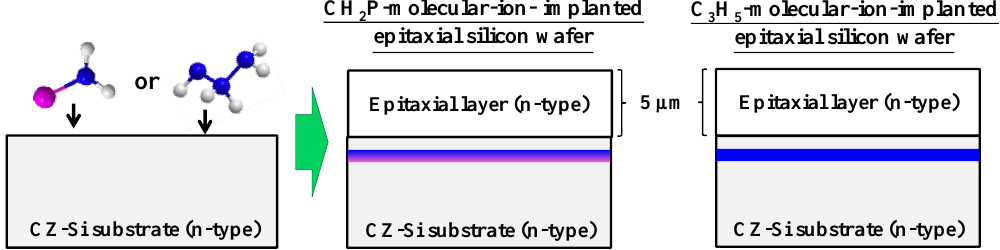
Figure 2. Cross-sectional structures of CH 2 P- andC 3 H 5 -molecular-ion-implanted epitaxial silicon wafers.